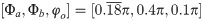
Validation through the total field for the wedge problem.Left: Total field obtained from the spectra in terms of GO and UTD components for the test case [Φa,Φb,φo]=[0.18¯π,0.4π,0.1π]. Right: Relative error on the computation of the total field in log10 scale of the numerical solution obtained with coarse numerical parameters A = 20, h = 0.025.